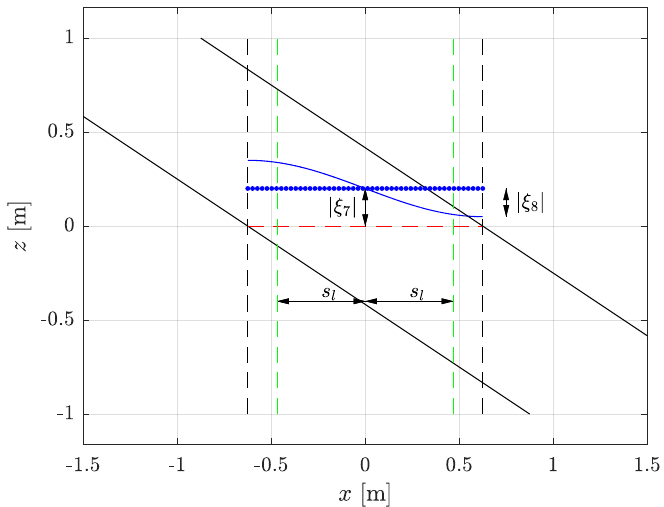
Figure 12. The WAMIT geometries used to compute the coefficients. In ( a ), the z = 0 plane coincides with the green internal chamber surface. In ( b ), the z = 0 plane lies at the top of the reflected geometry and the green internal chamber surface becomes a dipole patch at the level z = − h in a fluid of depth 2 h .